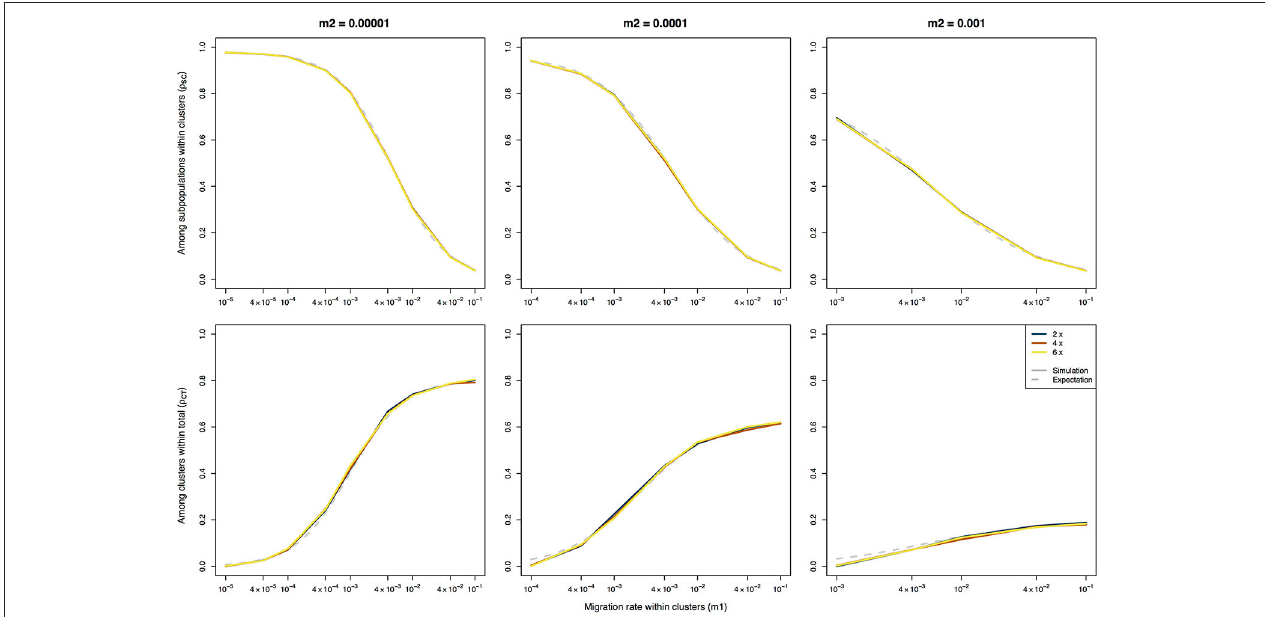
FIGURE 2 | Ploidy-independent ρ -statistics calculated using an AMOVA on data of three different ploidy levels simulated using a hierarchical island model of migration. The solid lines represent the results of the simulations, the dashed lines represent the expected values based on the derivations of Vigouroux and Couvet (2000). Note that the expectations are the same for all three ploidy